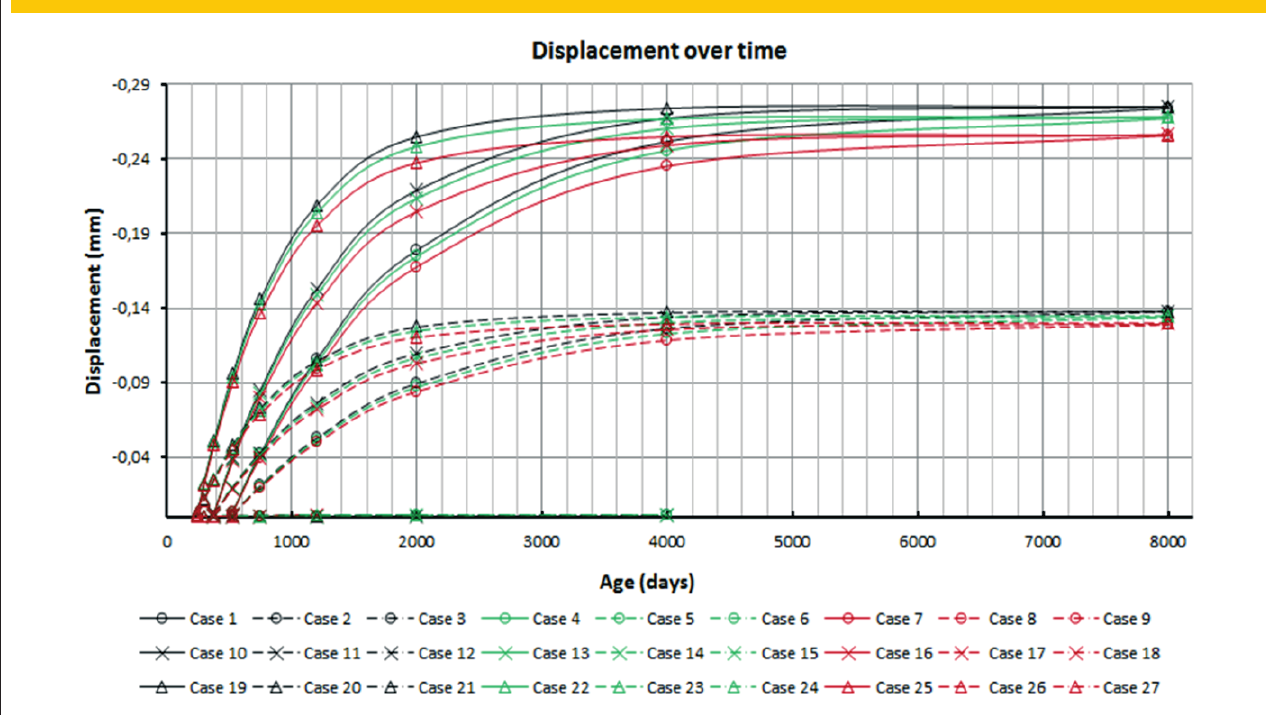
Figure 8 – Displacement on "x" direction due to AAR